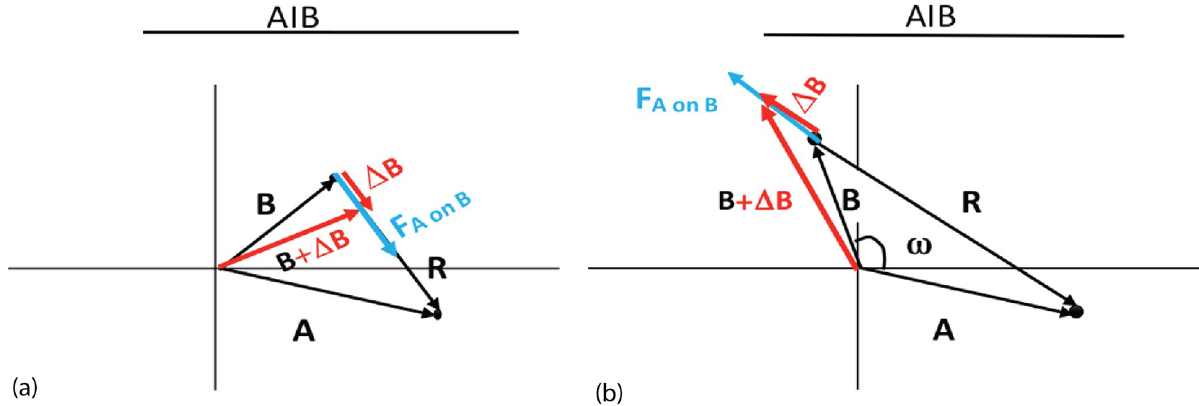
Fig 2. The force F in blue changes vector B to B + Δ B in red. a) attractive force which decreases the angle between A and B ; b) repulsive force AonB increases the